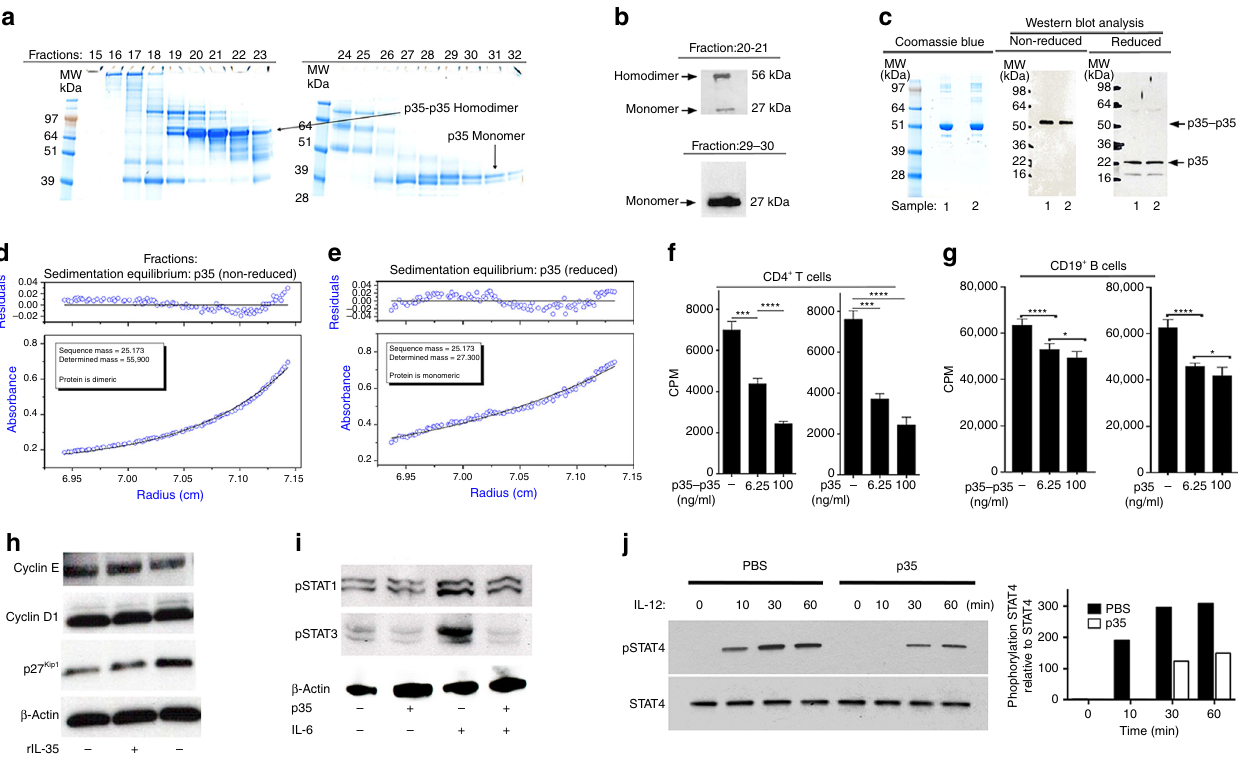
Fig. 1 p35 monomer and homo-dimer suppressed T and B cell proliferation. Secreted rIL-12p35 was partially puri fi ed by His-tagged af fi nity chromatography using Ni-NTA followed by two consecutive cycles of gel fi ltration using Supercryl S-200 (HR Hiprep 16/60) and Superose-6 (HR 10/30) FPLC columns. a rIL-12p35 in insect cell supernatant was sequentially puri fi ed by Ni-NTA Puri fi cation system, size-exclusion Centricon fi ltration and Supercryl S-200 chromatography. Protein from Ni-chelate af fi nity column was applied to a Sephacryl S-200 column and the elution prolife screened by SDS-PAGE under non-reducing conditions is shown. Analysis of the FPLC column fractions by non-denaturing SDS-PAGE indicates presence of p35 − p35 homo-dimer and p35 monomer in the rIL-12p35 preparation. b Fractions 20 – 21 (p35 − p35) and 29 – 30 (p35) were fractionated under non-reducing condition on SDS-PAGE and analyzed by the western blotting. c Further puri fi cation on Superose-6 FPLC column. Analysis of the main peak by non-reducing or reducing SDS-PAGE; Data from Coomassie Blue stained gel and western blot analysis are indicated. Samples 1 and 2 are duplicates. d , e The peak protein fraction from Superose-6 column was further puri fi ed by size-exclusion Centricon fi ltration and subjected to sedimentation equilibrium analyses under non-reducing d or reducing e condition. The p35 is clearly dimeric in the absence of reductant and monomeric when reduced. f Naive CD4 + T cells were stimulated with anti-CD3/CD28 in medium containing p35 or p35 − p35 and after 72h the effect of p35 or p35 − p35 on proliferation was assessed by [ 3 H]-thymidine incorporation assay. g Puri fi ed CD19 + B cells were stimulated with LPS for 2 days in medium containing p35 − p35 or p35 and analyzed by [ 3 H]-thymidine incorporation assay. h Puri fi ed CD19 + B cells were stimulated with LPS for 2 day in medium containing p35 or rIL-35 and analyzed by western blotting. i , j CD4 + T cells were stimulated with anti-CD3/CD28 for 3 days. The cells were then cultured in serum-free medium for 2 h, followed by stimulation with IL-6 or IL-12 for 10, 30, and/or 60min in the presence or absence of p35. Whole cell lysates were analyzed by western blotting using indicated Abs. Results represent at least three independent experiments and were analyzed using Student ’ s t -test (two-tailed). Data are mean ± SEM. (*** P < 0.001; **** P <